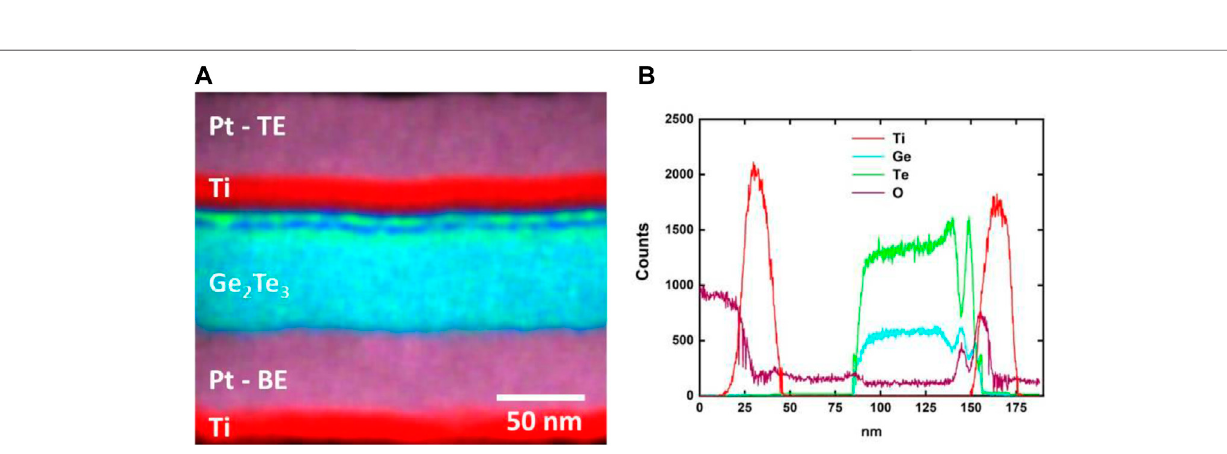
FIGURE 4 | (A) XEDS map and (B) elemental line pro fi les of overall device structure after electrical biasing. Note that the top and bottom Pt electrodes are abbreviated TE and BE, respectively.